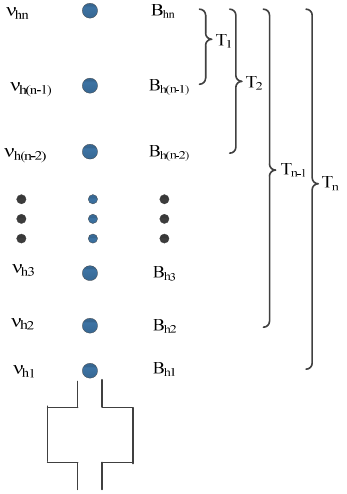
Figure 2. Diagram of integral solution for the central frequency of ( − 1, − 1) Ramsey transition.